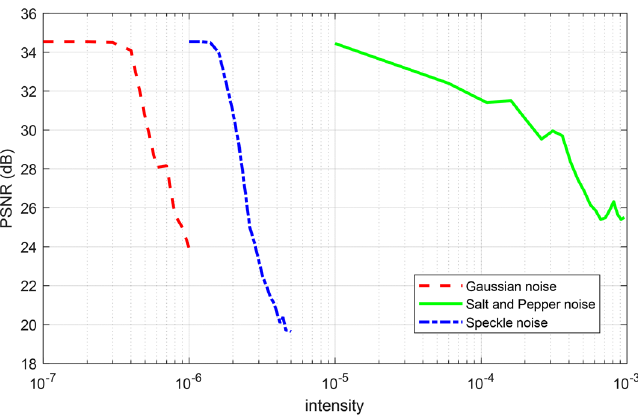
Figure 9. PSNR between decrypted images and original images with different noises.